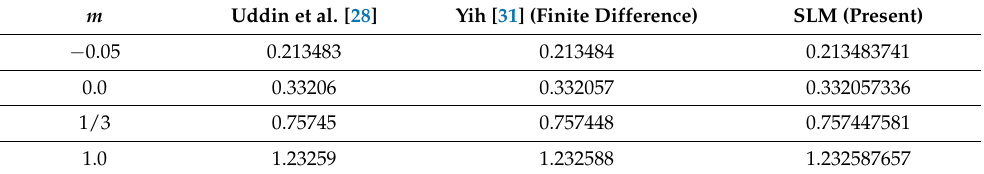
Table 3. Comparison of − f (cid:48)(cid:48) ( 0 ) when M = V = Ω = 0.0.